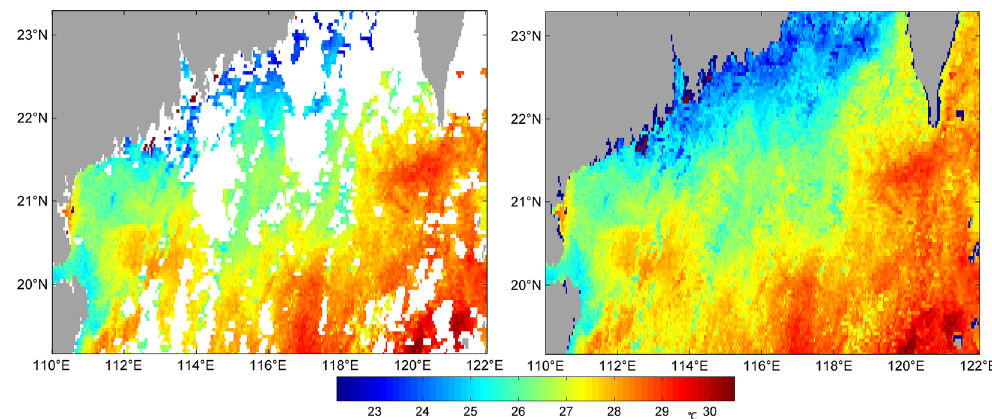
Fig 5. Left panel: original gappy image for 30 th April, 2012; right panel: its reconstruction image.